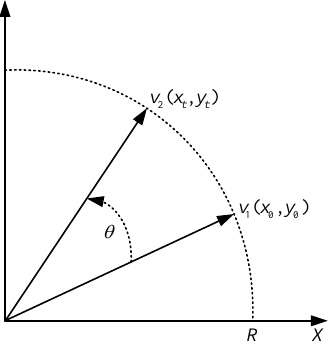
Figure 3. Rotation model for CORDIC algorithm.